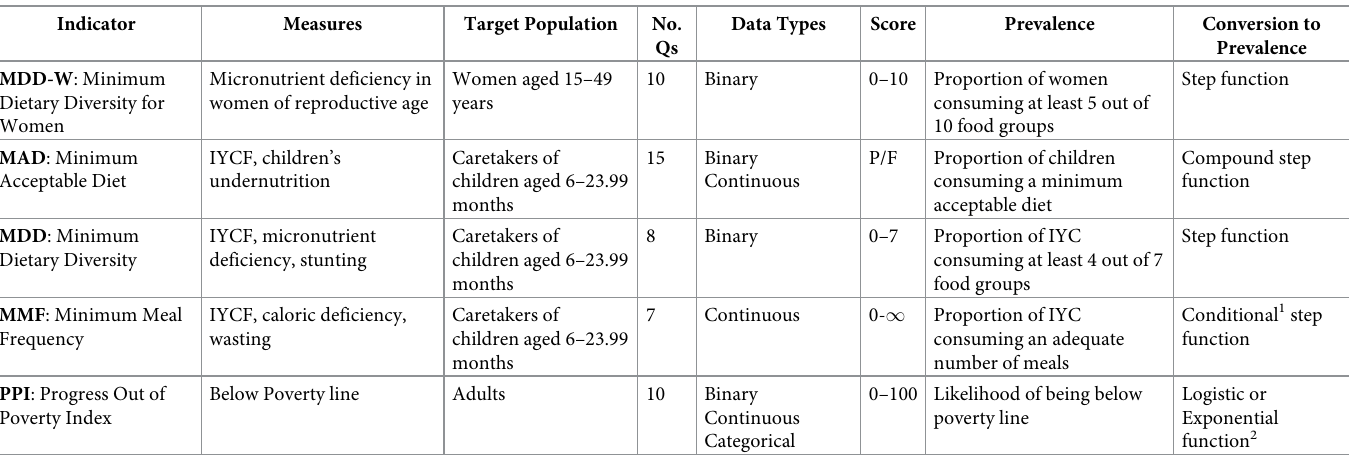
Table 1. Summary of